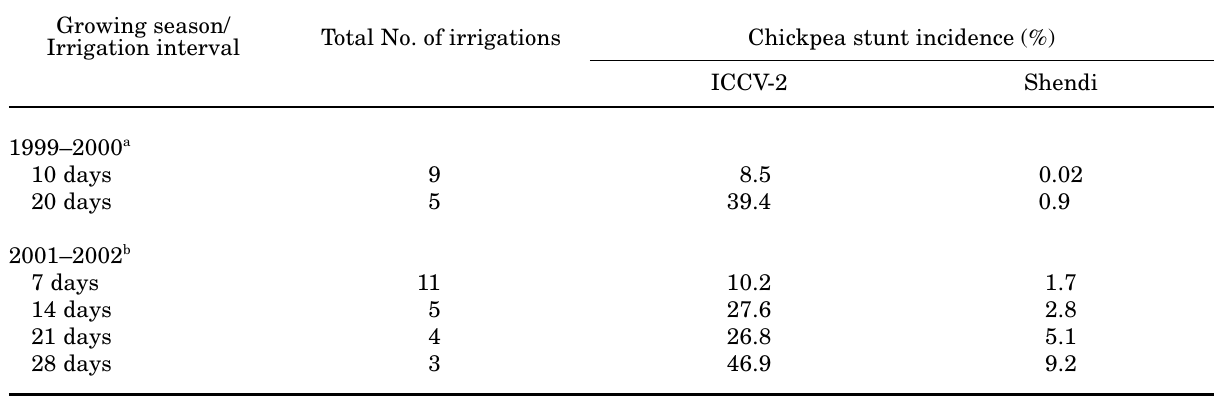
Table 4. Effect of irrigation intervals on chickpea stunt incidence at Hudeiba during the 1999–2000 and 2001–2002 growing seasons in two cheackpea cultivars, ICCV-2 and